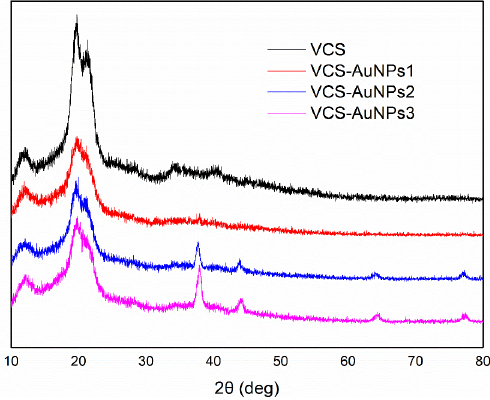
Figure 3. XRD analysis of VCS and AuNPs@VCS.